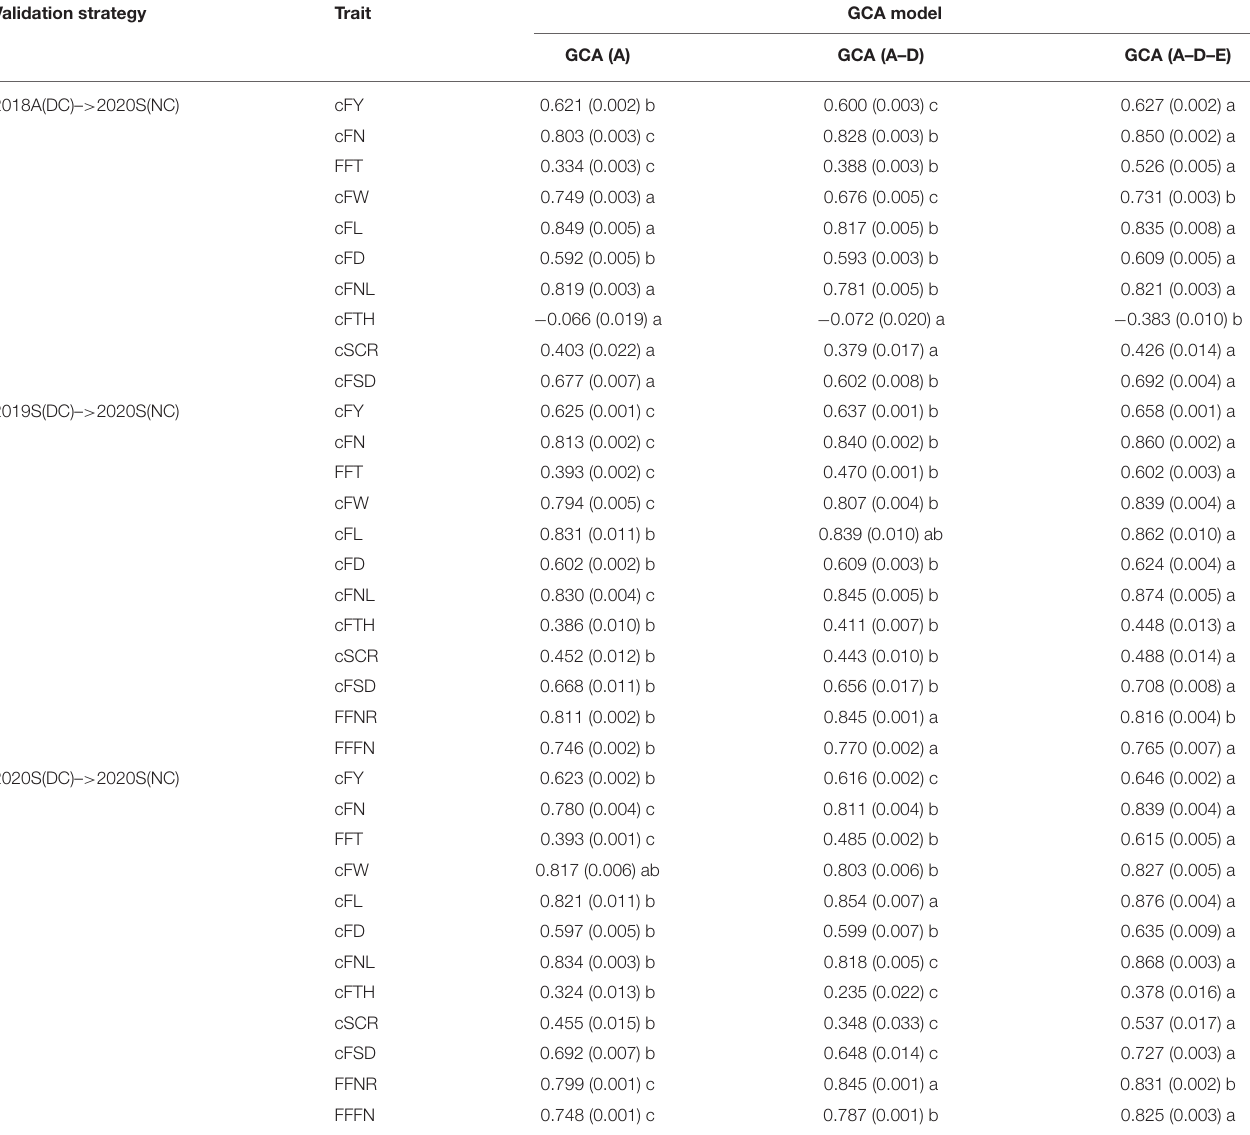
TABLE 3 | The model predictive ability under the cross-population strategy. Validation